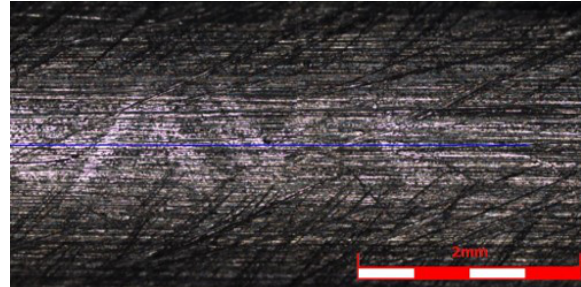
Figure 3. Surface of the tube